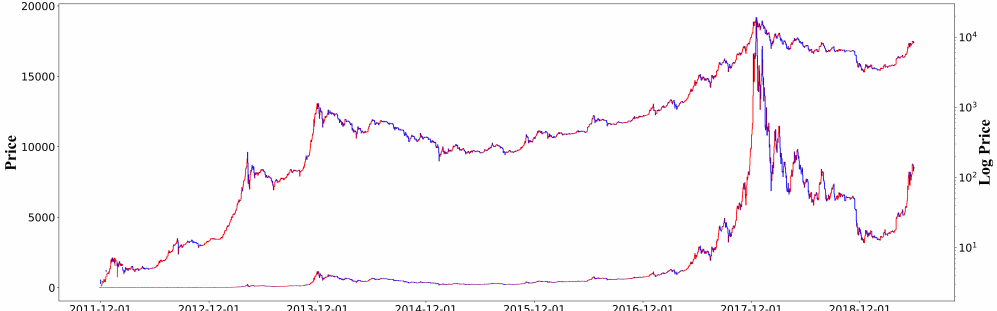
Figure 1. Bitcoin daily prices on Bitstamp (USD) from 29 November 2011 to 31 December 2018. The upper line shows log prices, whereas the lower line shows plain prices. Some recurring patterns seem to exist when considering the log value of the Bitcoin